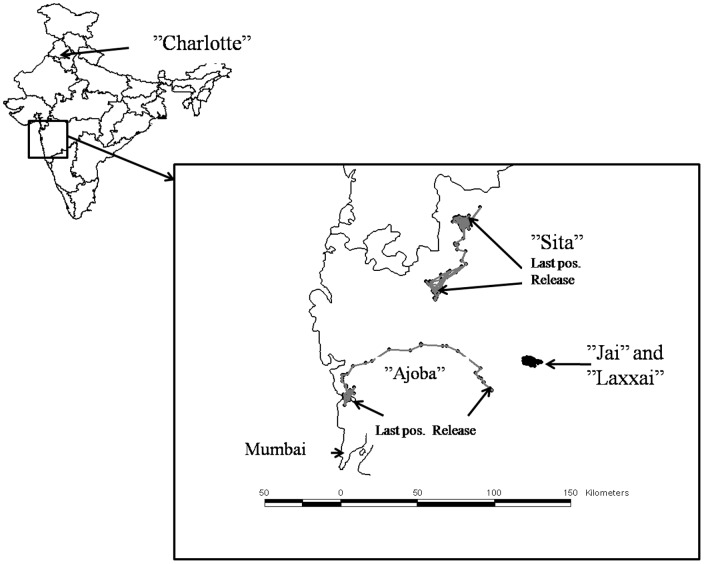
Overview of locations of five GPS-collared leopards captured in the states of Maharashtra and Himachal Pradesh, India.